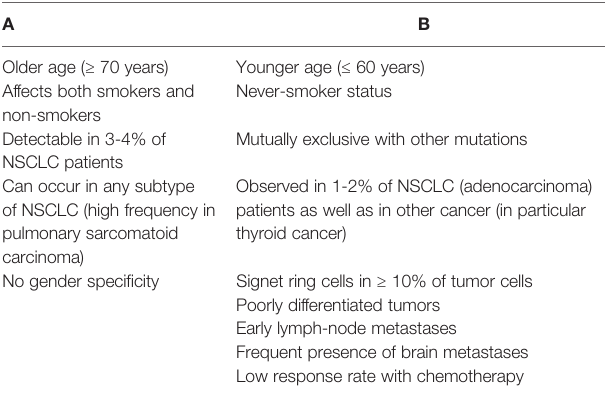
TABLE 1 | Clinical characteristics associated with MET exon 14 mutation/MET ampli fi cation (A) and RET deregulation (B) . A B Younger age ( ≤ 60 years) Affects both smokers